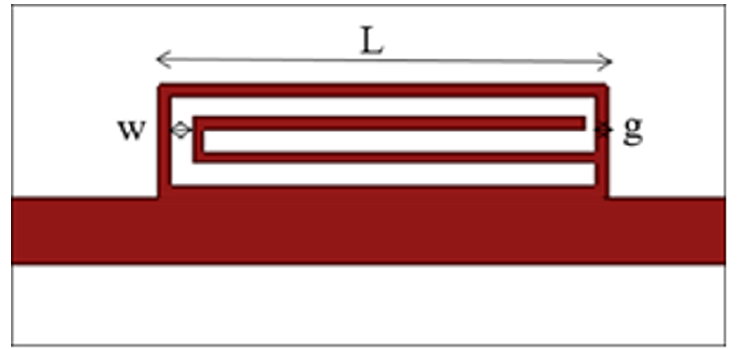
Figure 3. Geometry of single bit RFID tag